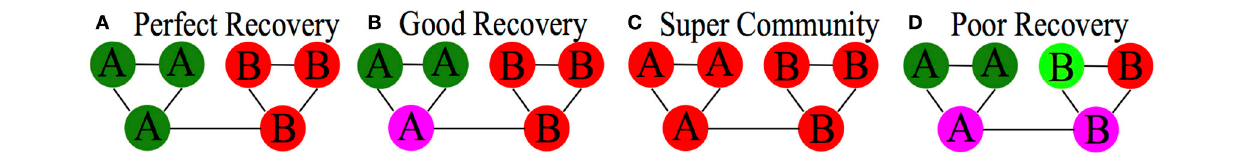
FIGURE 1 | Conceptual depiction of types of accuracy. (A) “Perfect Recovery” refers to all nodes being placed in the correct community; (B) “Good Recovery” reflects nodes being placed in the correct community most of the time; (C) “Super Community” indicates a phenomenon where nodes are subsumed into one large community; (D) “Poor Recovery” is when nodes are simply placed in communities with other nodes erroneously. (A) indicates ARIHA of 1.00; (B) would have < 1.00; (C,D) would be closer to